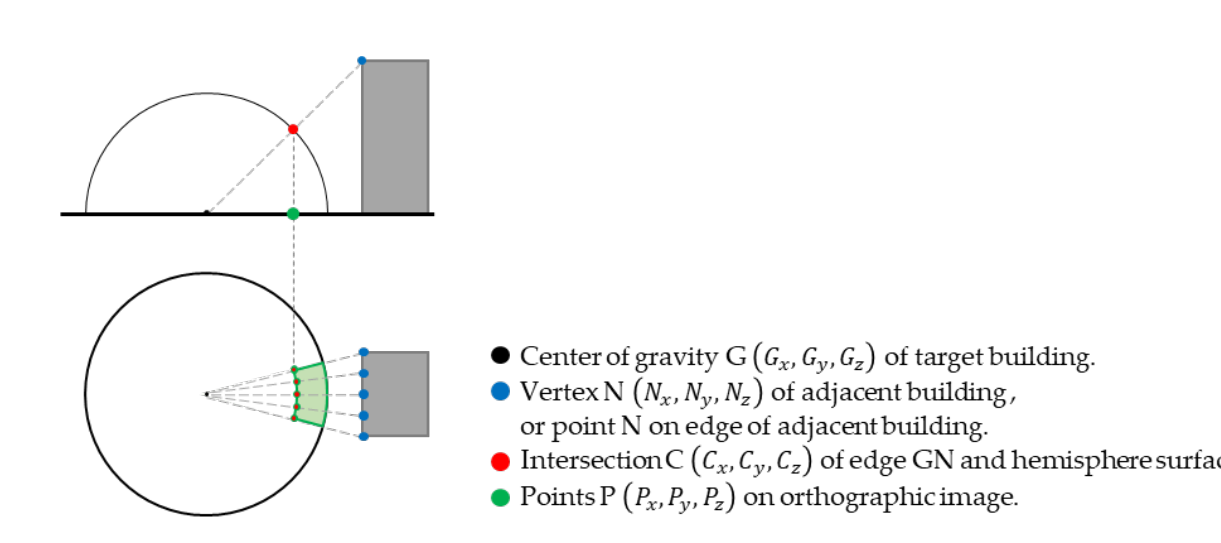
Figure 3. Method of projecting adjacent buildings onto positive orthographic image. The green points in Figure 3 are the points P These points are projected from point C onto the positive projection image. Each point P